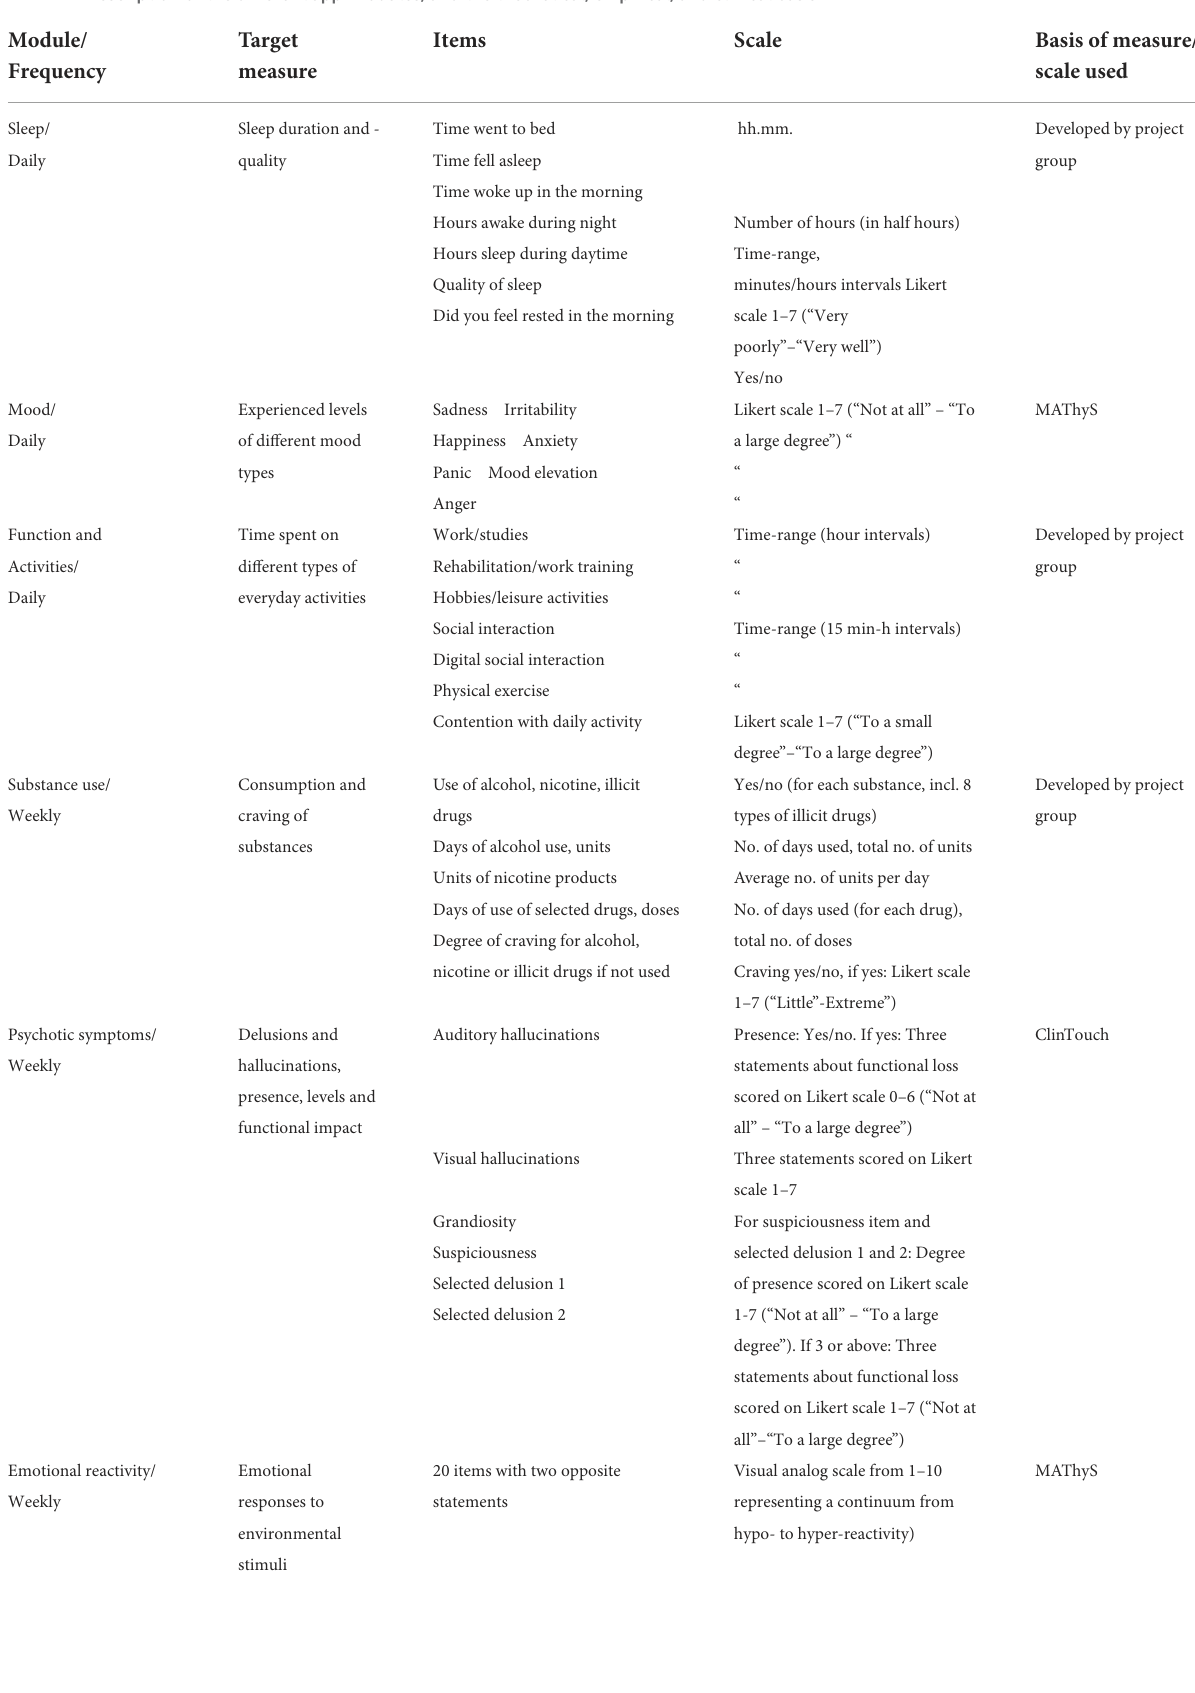
TABLE 1 Description of the different app-modules, and the theoretical, empirical, and clinical basis. Module/